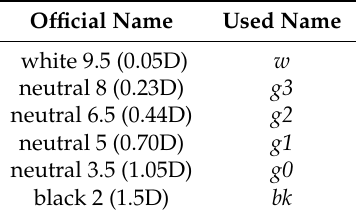
Table 1. Color Name